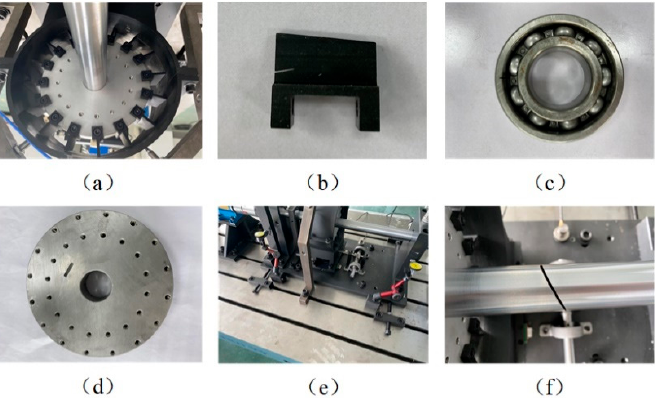
Figure 8. Six different fault states: ( a ) full annular rub; ( b ) blade crack; ( c ) bearing fault; ( d ) blisk crack; ( e ) Shaft coupling fault; ( f ) Shaft crack.